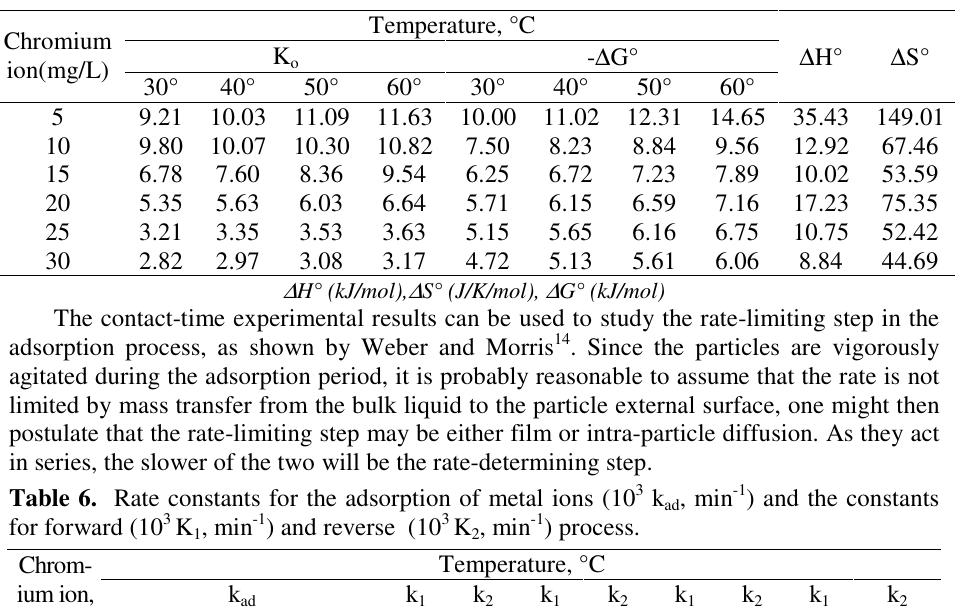
Table 5. Equilibrium constant and thermodynamic parameters for the adsorption of metal ions onto acid activated carbon.